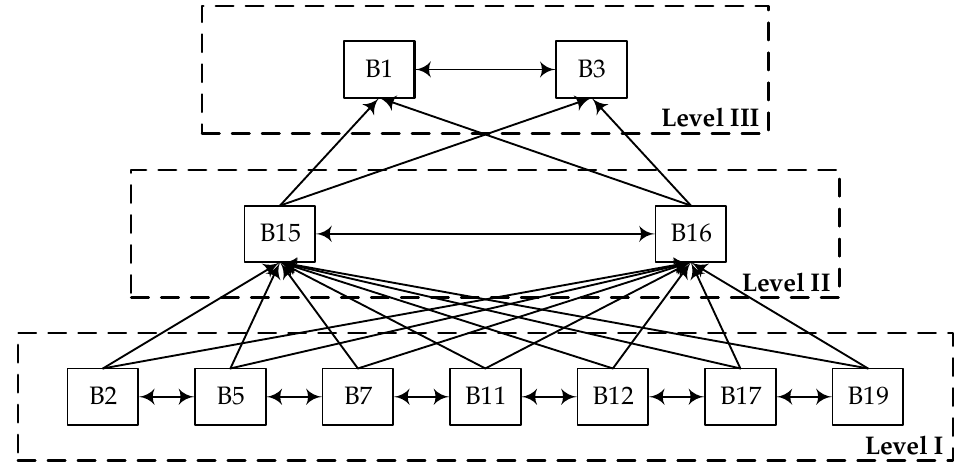
Figure 7. The level partitions of this research analysis.